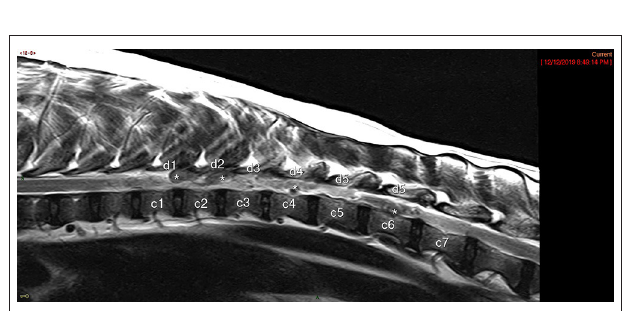
FIGURE 2 | T2w Sagittal MRI image showing spinal compression count noted as “c” and surgical decompression count noted as “d.” This patient had a compression:decompression ratio of 1.16. An * denotes representative areas of DEEH intervertebral disk